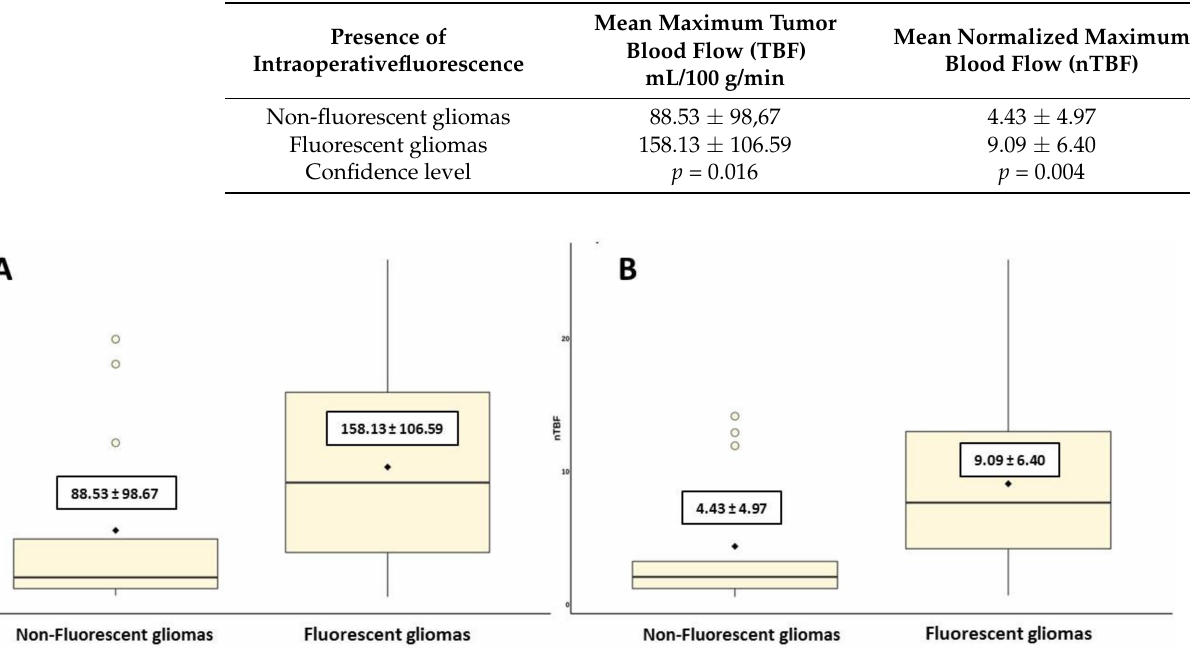
Figure 1. A plot diagram showing blood flow in groups of fluorescent and non-fluorescent gliomas using the values of maximum tumor blood flow ( A ) and maximum normalized tumor blood flow ( B